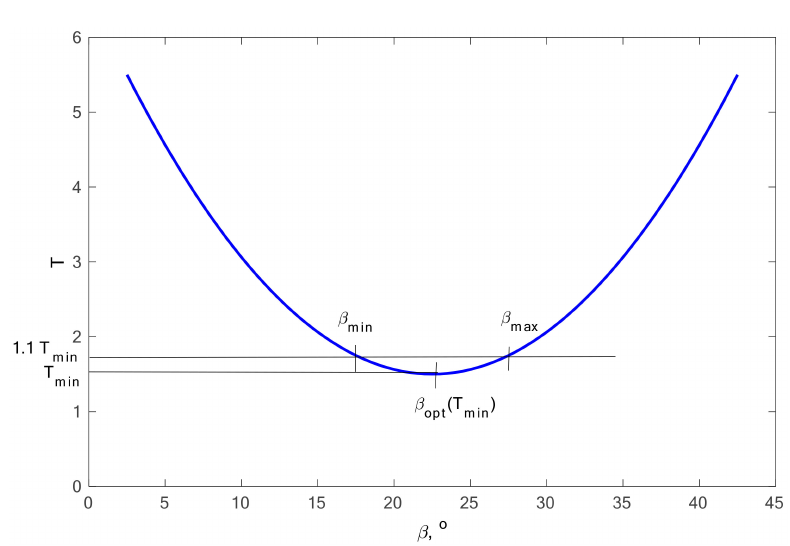
Figure 6. Methodology of presented assumptions—condition